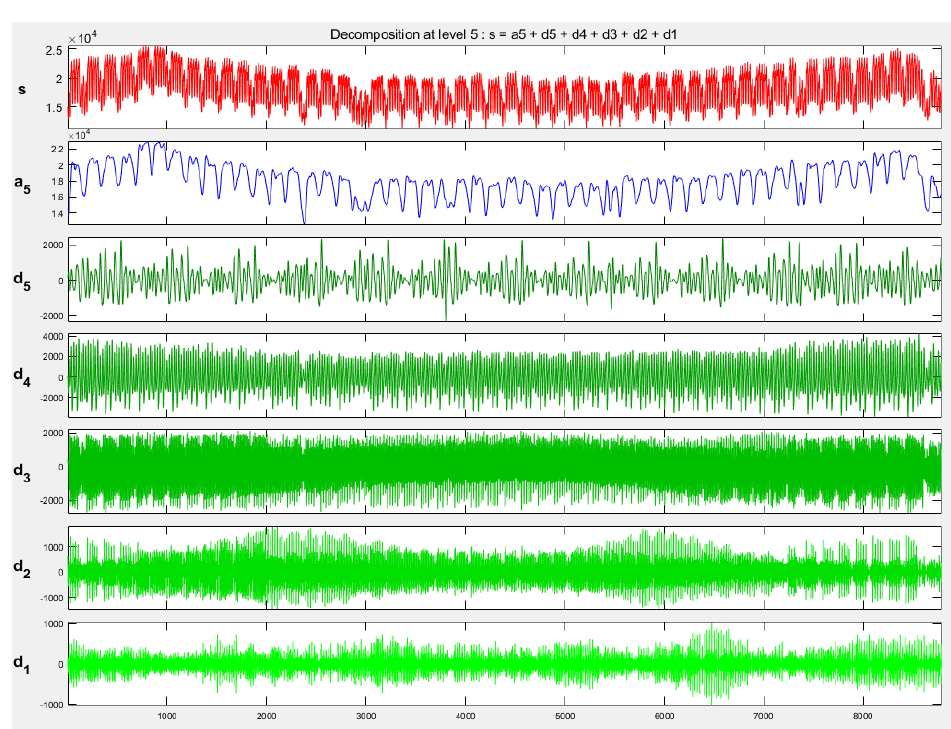
Figure 6. The graphical results of wavelet decomposition of the time series represent the hourly load of one year. The upper curve represents the original time series s , a 5 —the coarse approximation on 5th level, and d 1 –d 5 —the detailed wavelet representation of the analyzed signal s on five levels.